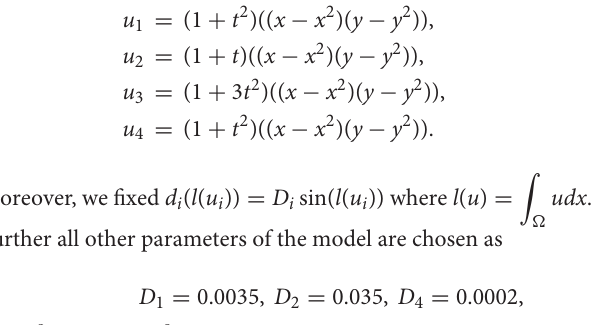
Frontiers in Physics |